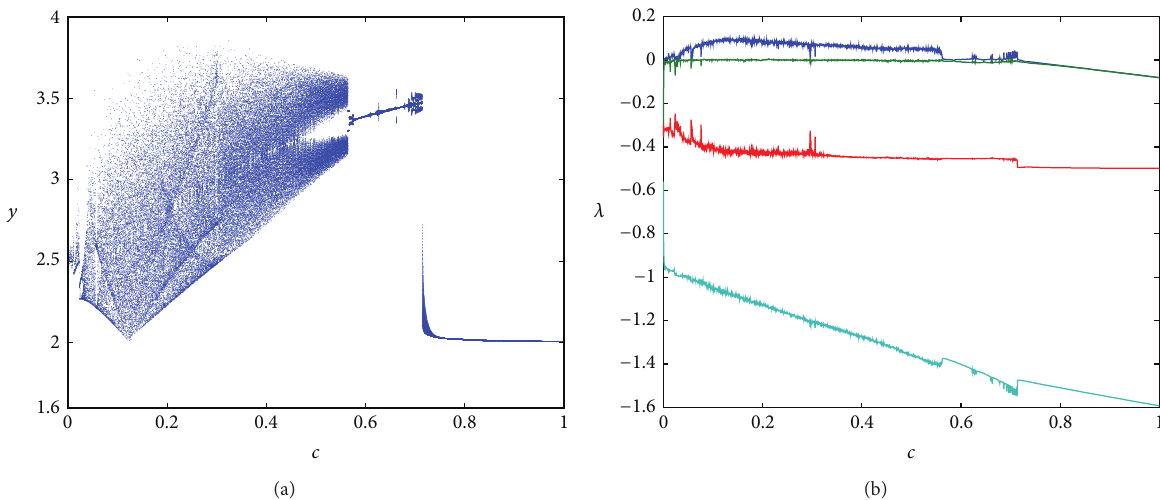
Figure 11: Nonlinear dynamics of controlled system (16) for specific values 𝑎 = 1 , 𝑏 = 2 versus the control parameter 𝑐 . (a) Bifurcation diagram of 𝑦 . (b) Lyapunov exponent spectrum.